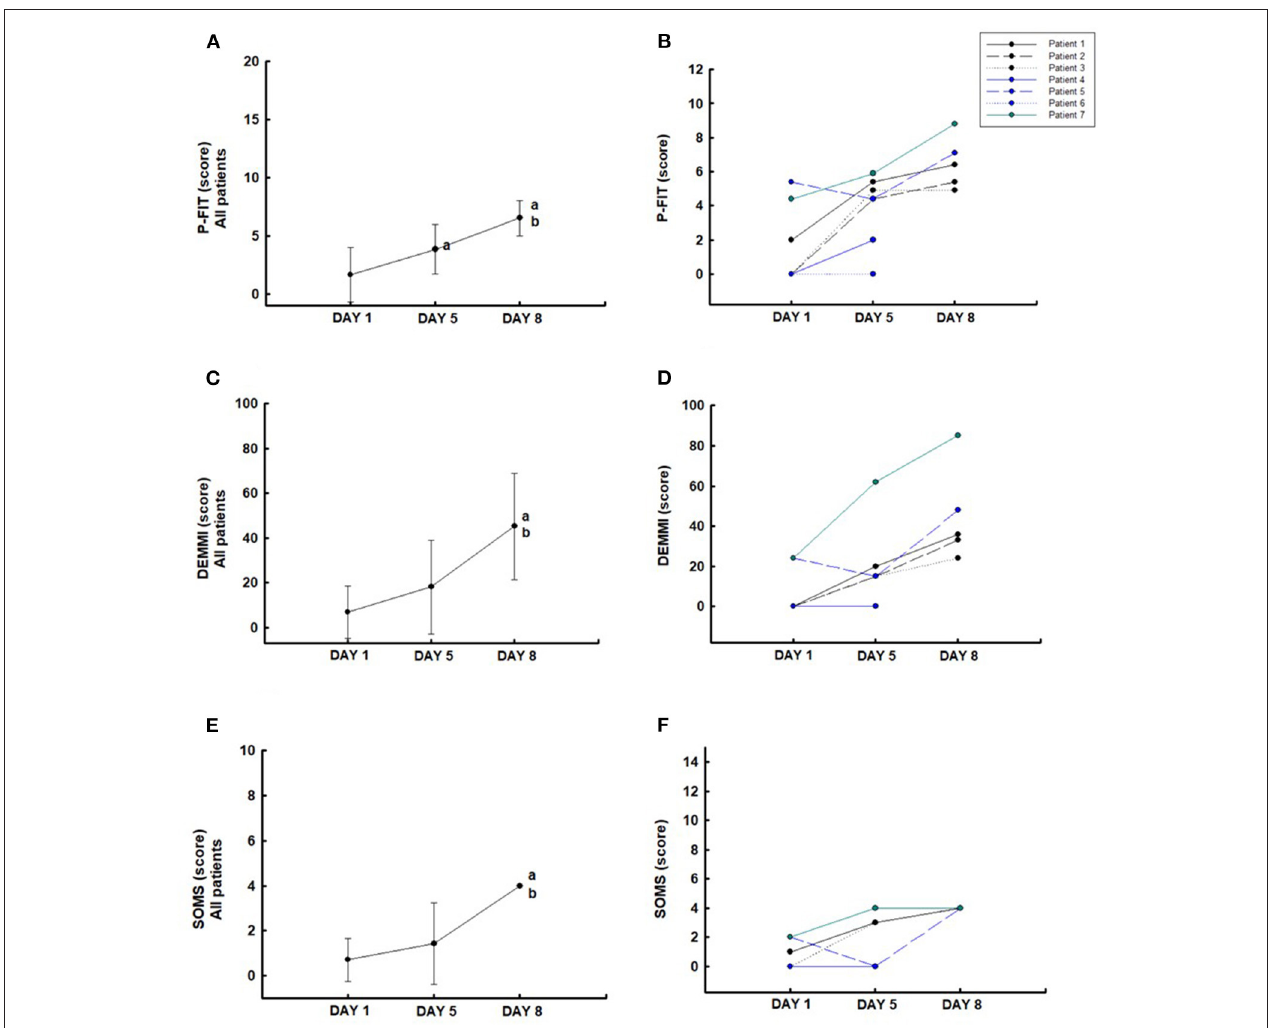
FIGURE 3 | Functionality: Physical Function ICU Test-scored (PFIT-s) (A,B) , Morton Mobility Index (DEMMI) (C,D) , and the Surgical Intensive Care Unit Optimal Mobilization Score (SOMS) (E,F) . a P < 0.05 compared to day 1; b P < 0.05 compared to day